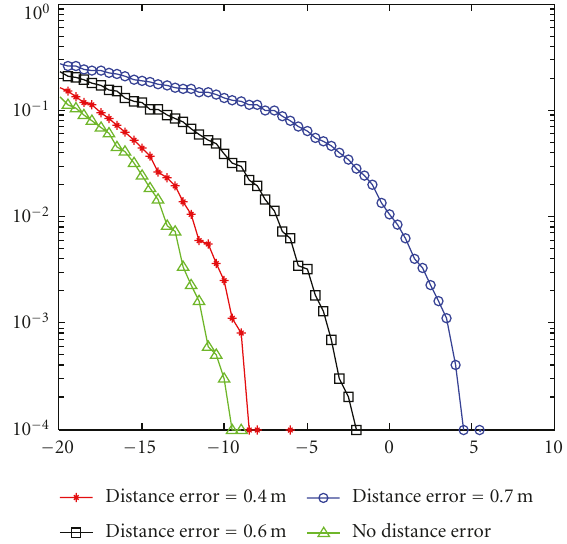
Figure 9: BER performance when exists distance